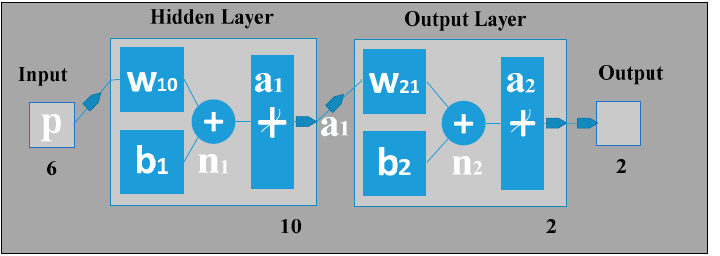
Figure 10. The 3-layer back propagation artificial neural network (BP-ANN) topology used for this work.